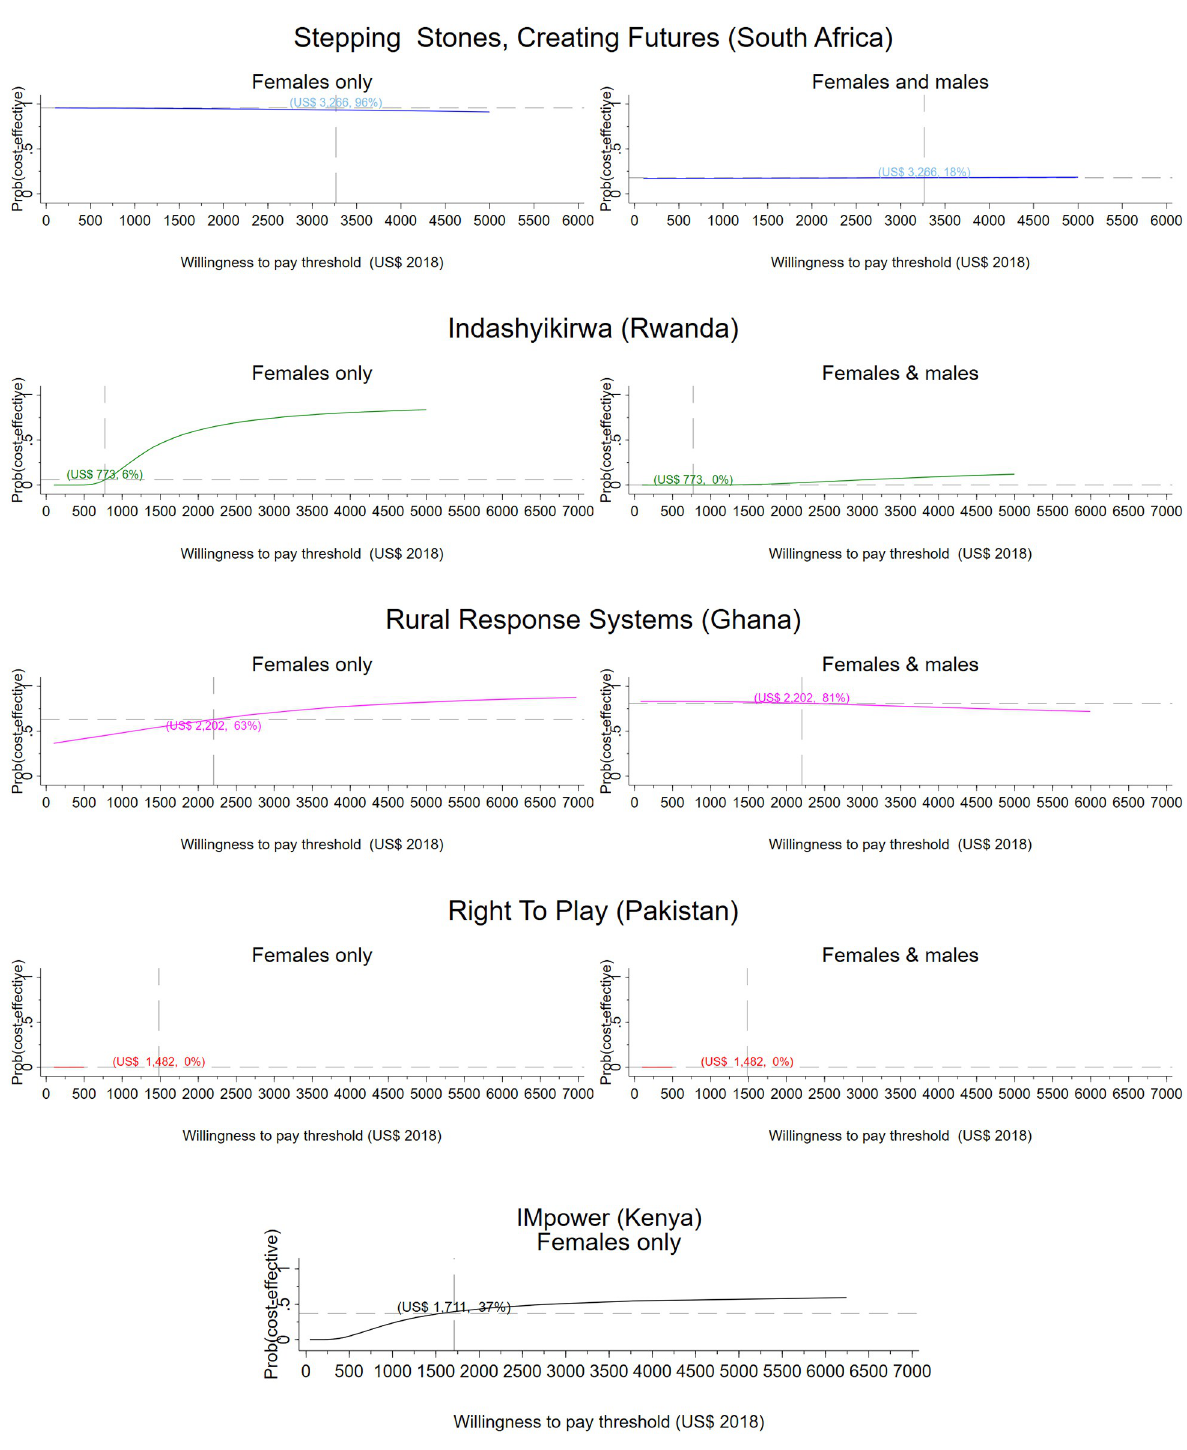
Fig 6. Scale-up scenario 2, societal perspective. CEACs illustrating the probability that the intervention is effective for a range of thresholds. Dashed vertical line: country-specific opportunity cost threshold; dashed horizontal line: probability that the intervention is cost-effective at the country-specific threshold, given the cost per DALY averted by the intervention. DALY, disability-adjusted life year.